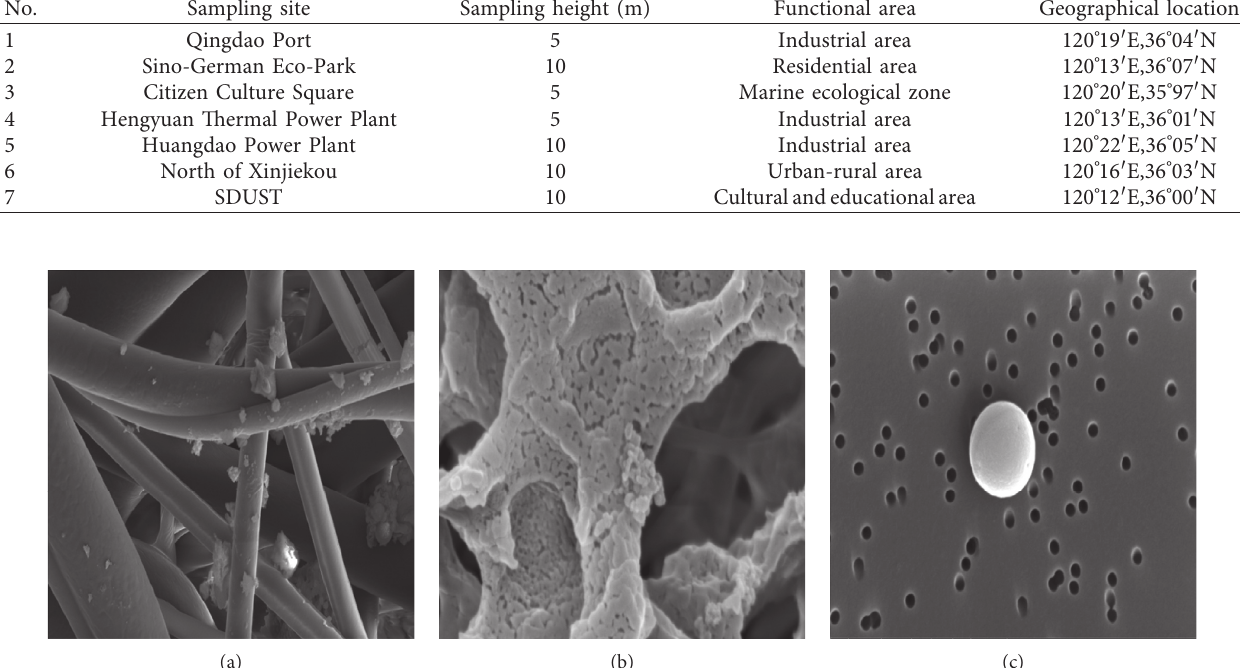
Figure 1: Samples of three filter membranes: (a) quartz fiber filter membrane; (b) cellulose acetate filter membrane; (c) polycarbonate filter film